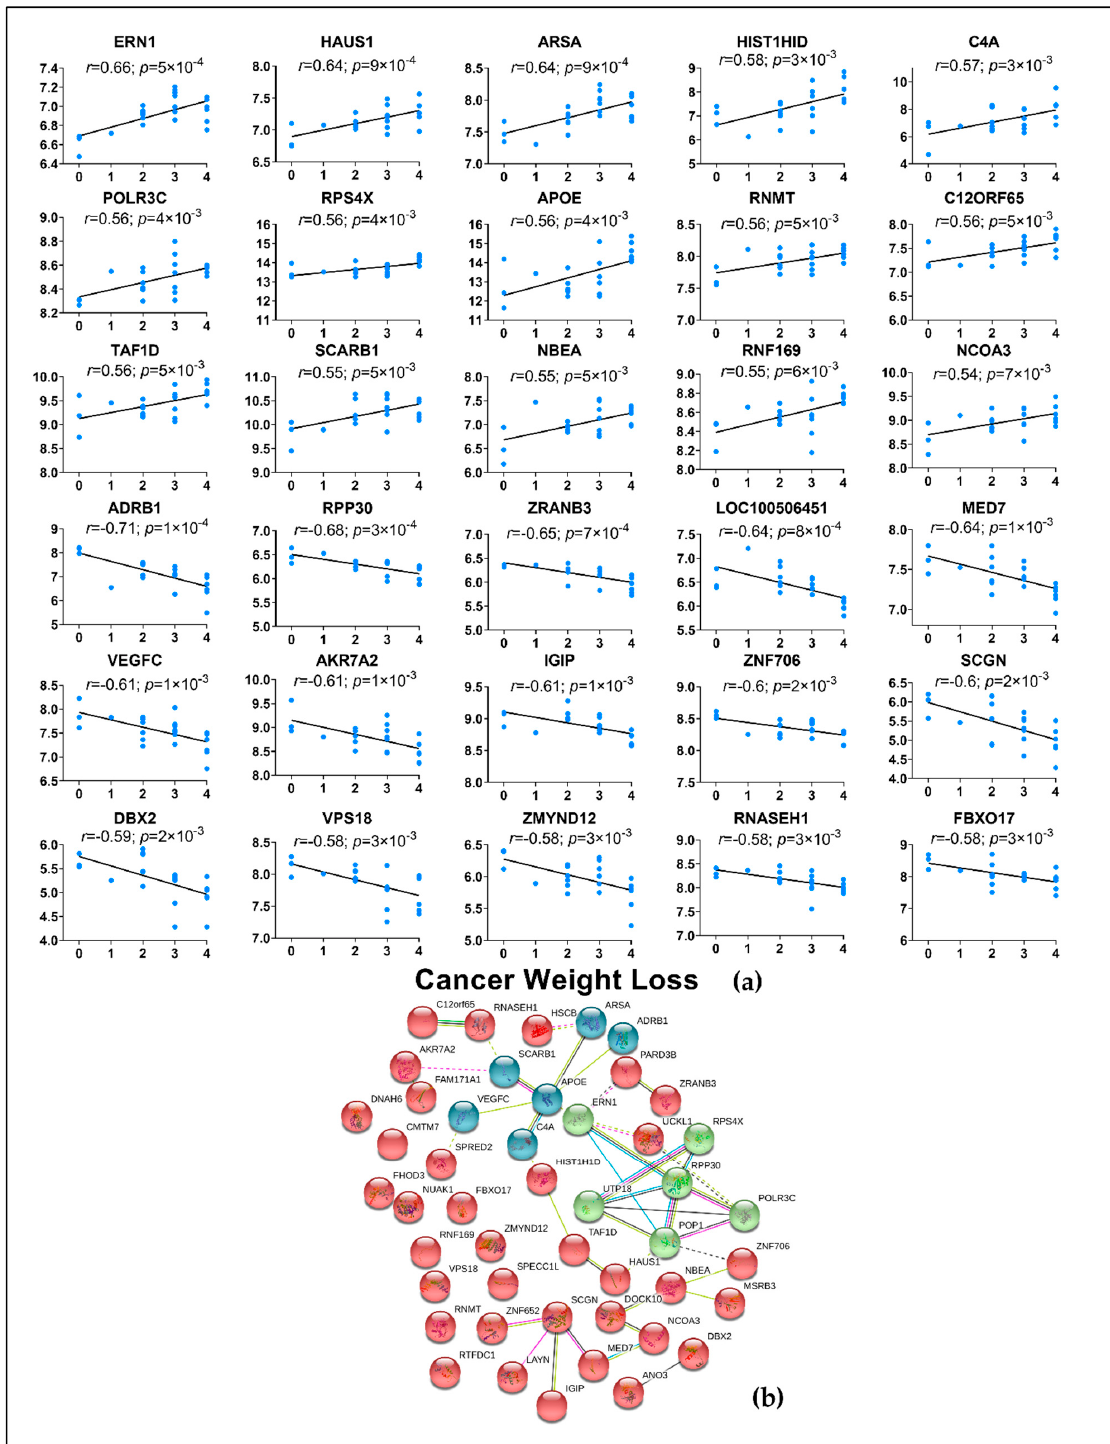
Figure 8. Top 30 adipose genes correlated with CWLG and gene network. ( a ) All genes were correlated against CWLG with PDAC samples alone. Spearman’s rank correlation was performed and only genes with r > 0.5 and p < 0.05 were considered and 98 genes correlated with CWLG; ( b ) the network was generated using the STRING database for the top 50 correlated genes with CWLG.